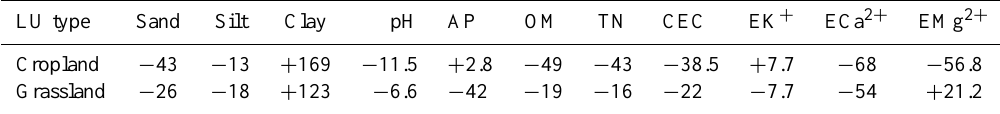
Table 4. Percentage changes in selected soil properties in cultivated and grazing land uses compared to forestland in northeastern Wellega, Ethiopia. LU type Sand Silt Clay pH